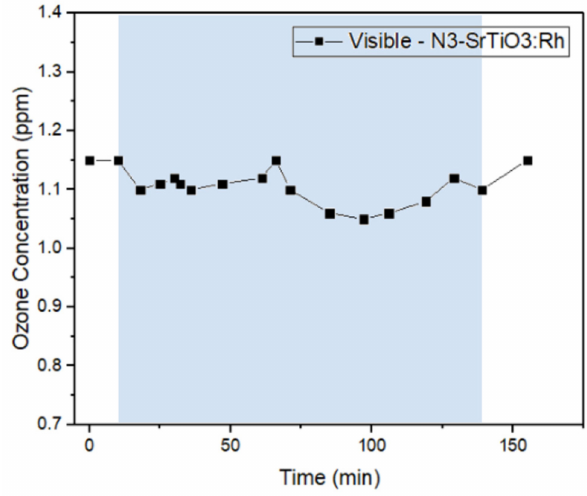
Figure 5. Photocatalytic decomposition of ozone in the continuous flow system by N3-SrTiO 3 :Rh (N3 dye sensitized rhodium-doped strontium titanate) under the halogen lamp (OSRAM, 50 W, broad band, with 400–500 nm bandpass